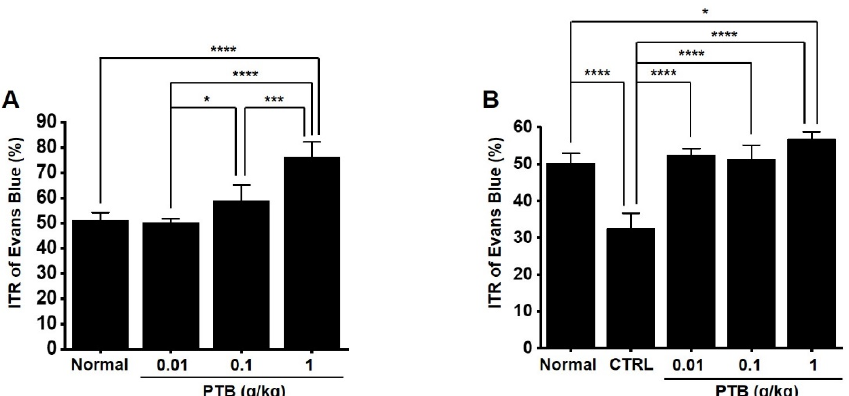
Figure 9. Effects of PTB extract on the intestinal transit rate (ITR) in normal and gastrointestinal motility disorder (GMD) mice. ( A ) PTB extract increased the ITR. ( B ) The ITR was recovered by PTB extract in GMD mice. Means ± SEs. * p < 0.05. *** p < 0.001. **** p < 0.0001. PTB: Pinellia ternate Breitenbach. CTRL: control.